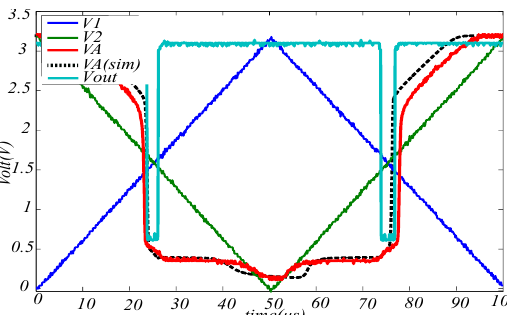
Figure 16. Measurement results of VA and Vout at 10 kHz frequency. The dashed black curve is the simulation result with same parameters.